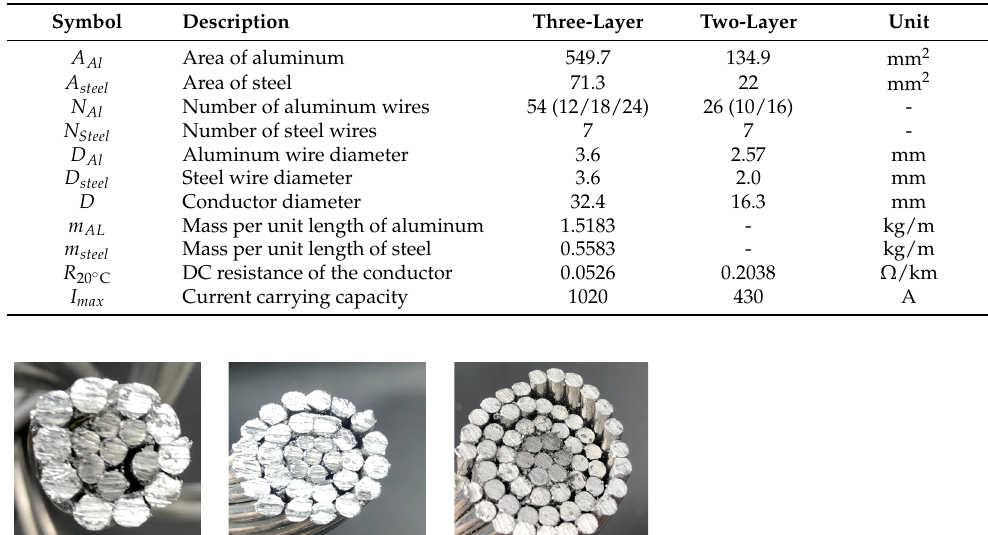
Table 1. Main parameters of the three-layer 550-AL1/71-ST1A ACSR conductor from HAASE Gesellschaft and the two-layer 135-AL1/22-ST1A ACSR conductor from EMTA Kablo.